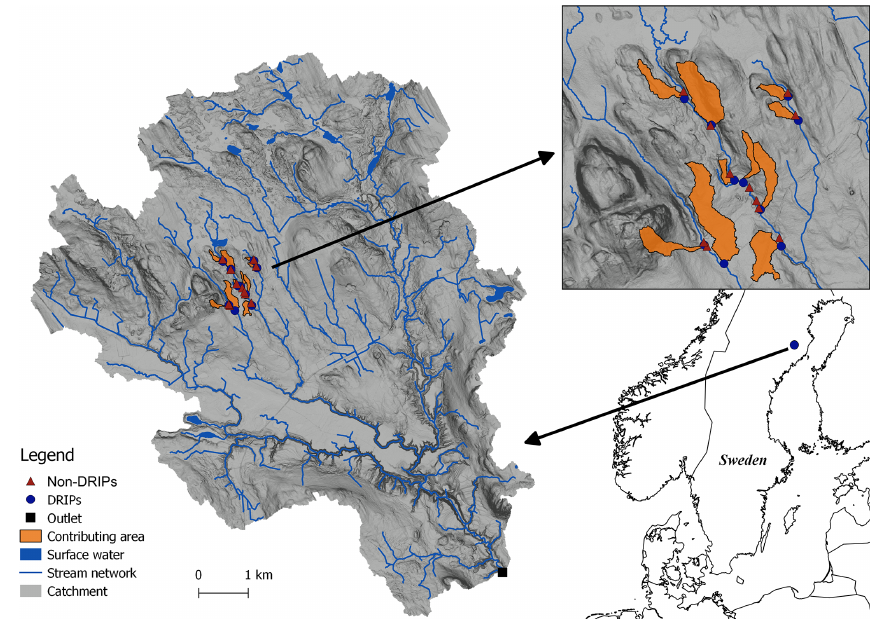
Figure 2. Krycklan catchment in northern Sweden. The upper right panel shows the particular study area where the well network was installed. The red triangles and blue dots indicate non-DRIP and DRIP transects, respectively, which consist of three wells placed at 20, 10, and < 5m from the stream. The black square indicates the catchment outlet. The contributing areas of each well transect are indicated in orange. Non-DRIP contributing areas are typically too small to be